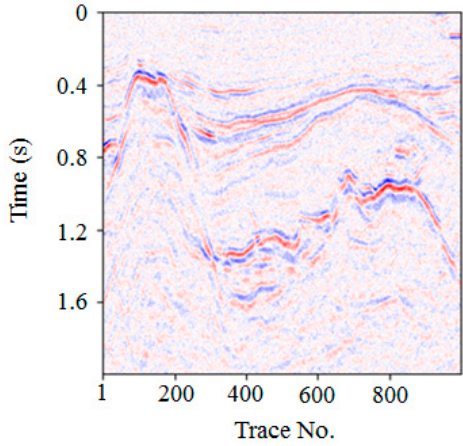
Figure 11. Real seismic data.